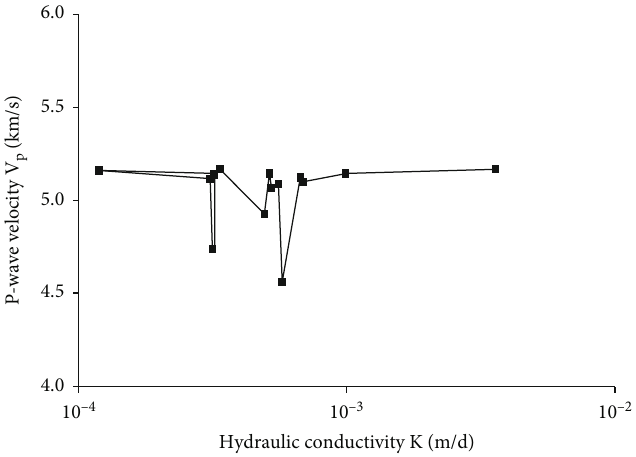
Figure 7: Relationship curve between hydraulic conductivity ( K ) and P-wave velocity ( V